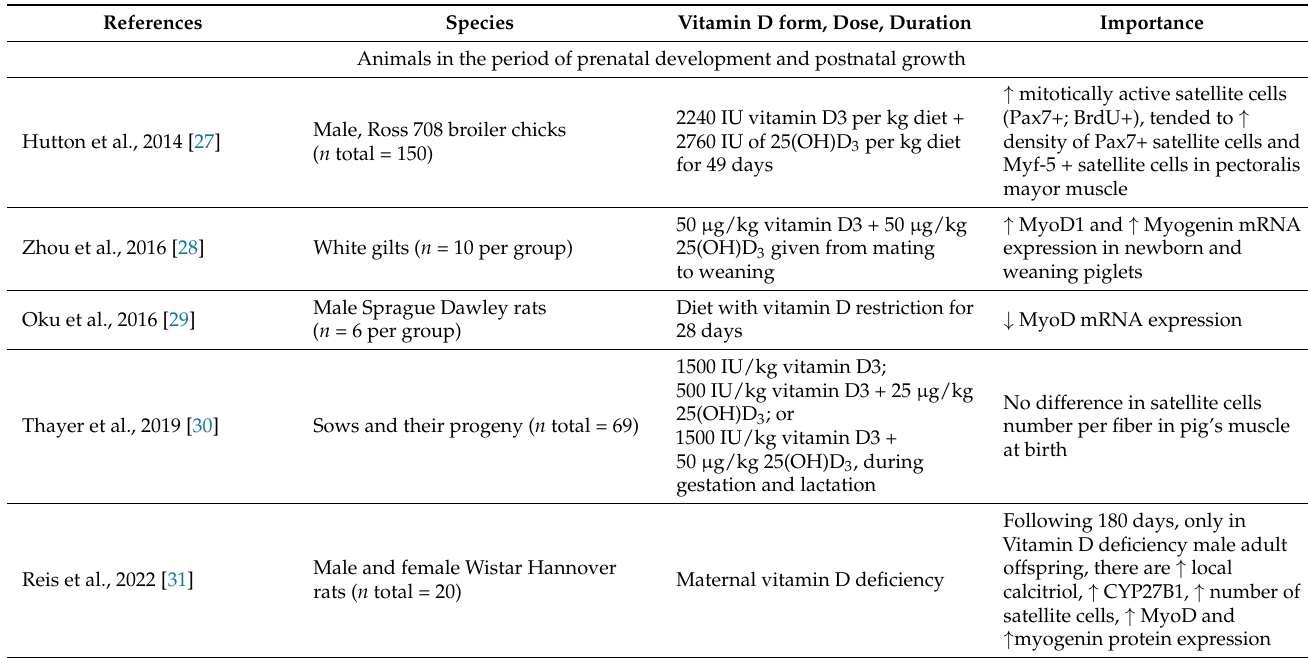
Figure 2. Study selection flow adapted from Preferred Reporting Items for Systematic Reviews and Meta-Analyses (PRISMA) guideline [26]. Table 1. Characteristics of selected in vivo studies stratified based on the characteristics of experi- mental animal